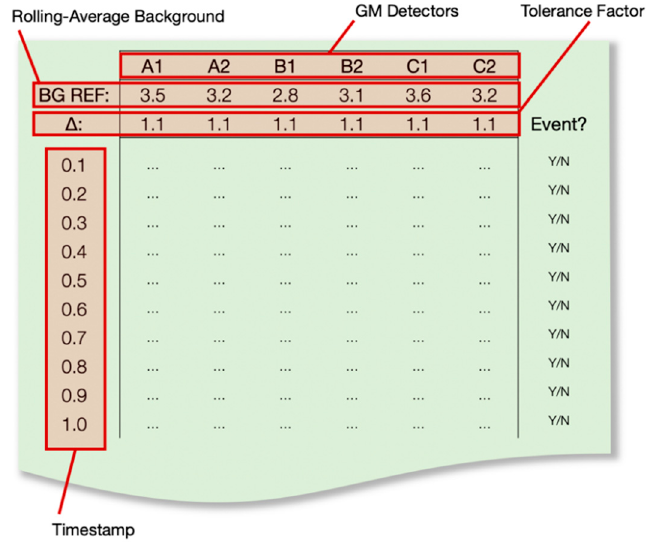
Figure 4. Schematic of the GM detection measurement matrix array populated following the triggering of the IR proximity sensor at the entrance to the Speed Gate™.